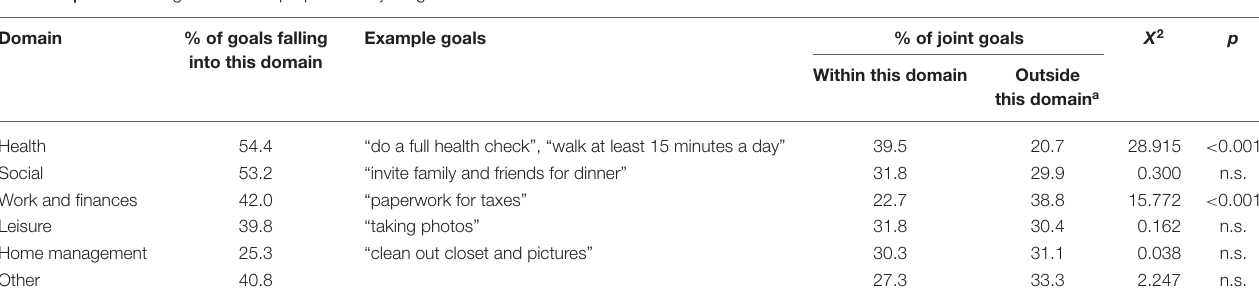
TABLE 2 | Domains of goals and the proportion of joint